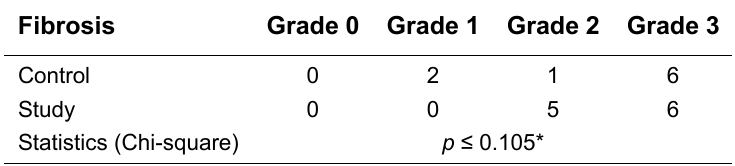
Fibrosis Grades of the Study and Control